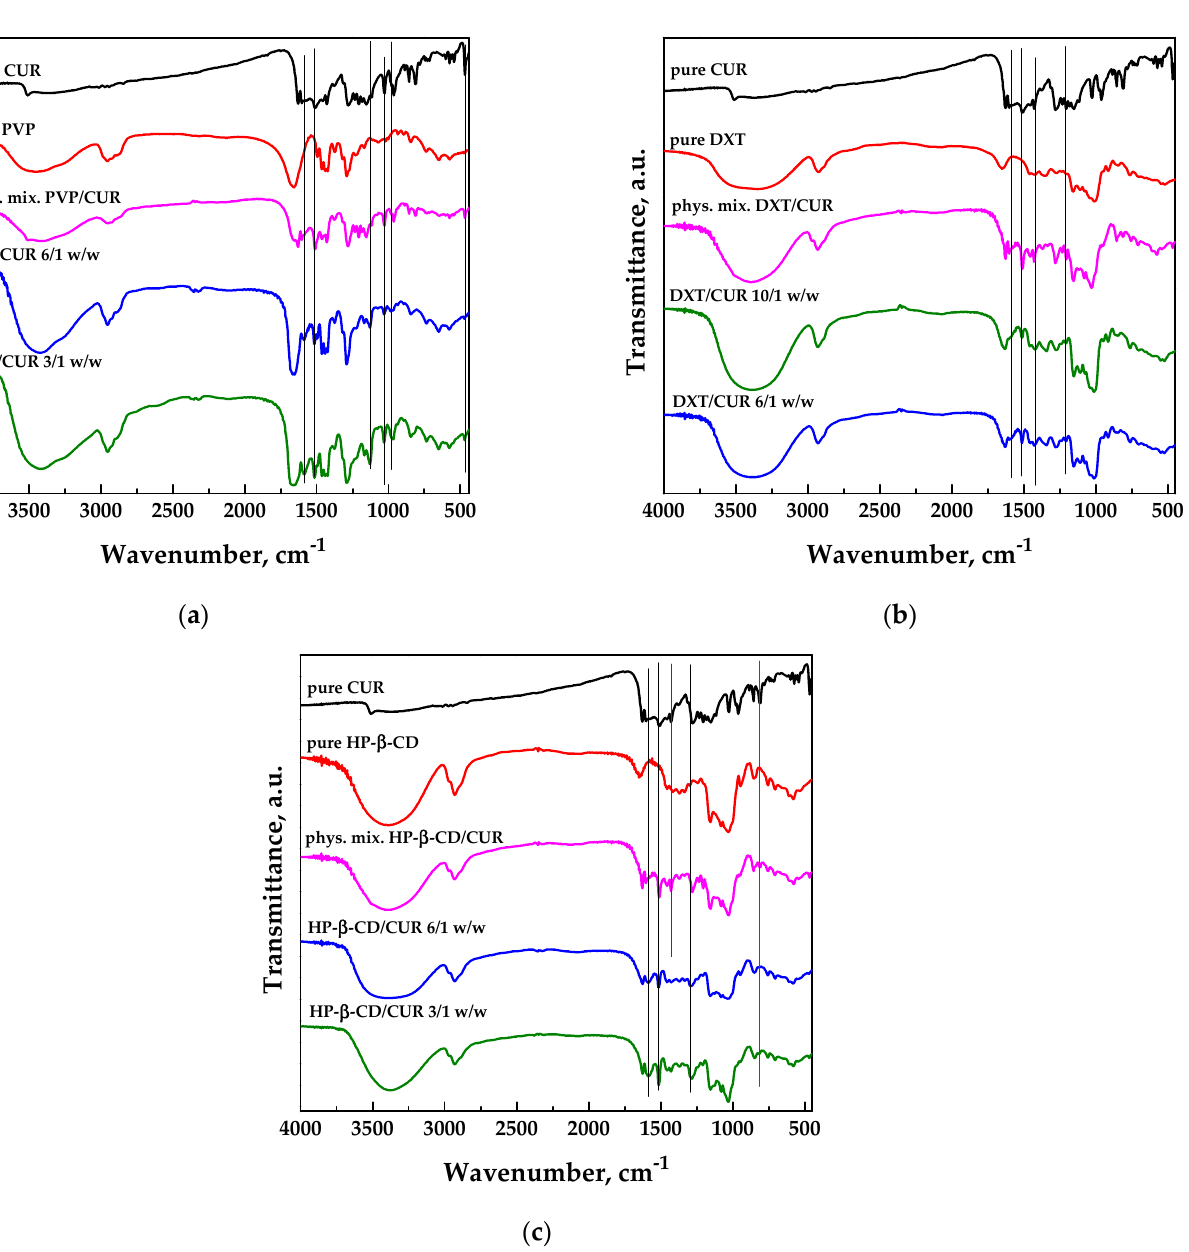
Figure 5. FT-IR spectra of unprocessed, physical mixtures and SAA processed carrier/CUR powders: ( a ) PVP; ( b ) DEX; ( c ) HP- β -CD.